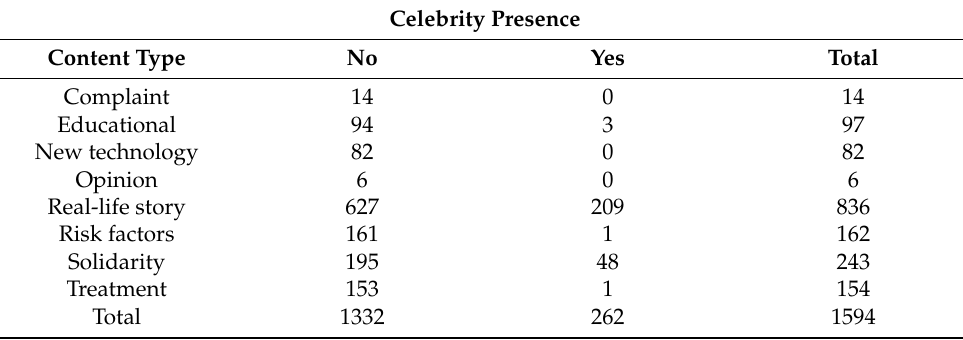
Table 3. Celebrity presence in our sample according to content